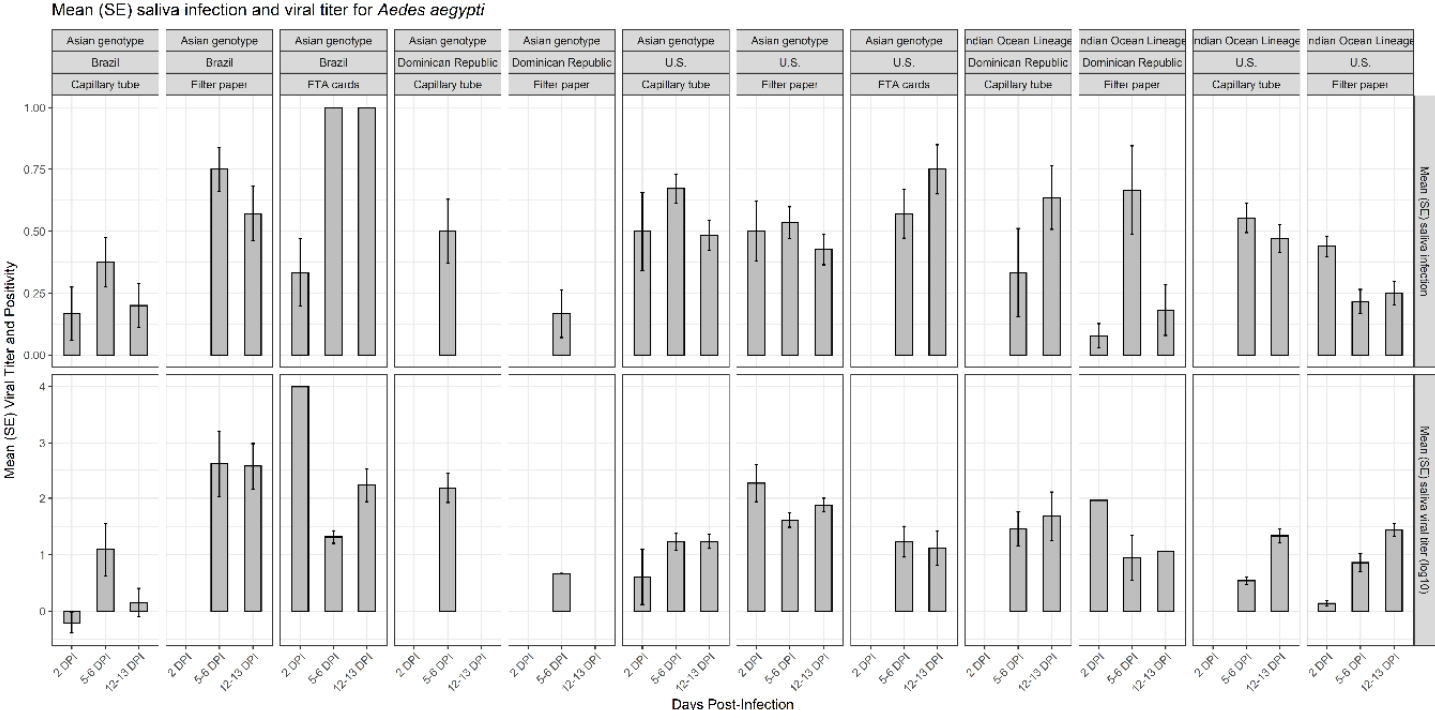
Figure 1. Mean (SE) proportion of saliva infection and viral titer (log 10 pfue / mL) of Ae. aegypti females from Brazilian, Dominican Republic, and US populations, measured by three different methods (capillary tube, filter paper, and FTA card) at different days post-infection (DPI; 1 = 2 DPI, 2 = 5 to 6 DPI, 3 = 12 to 13 DPI), for two CHIKV genotypes (Asian and IOL).